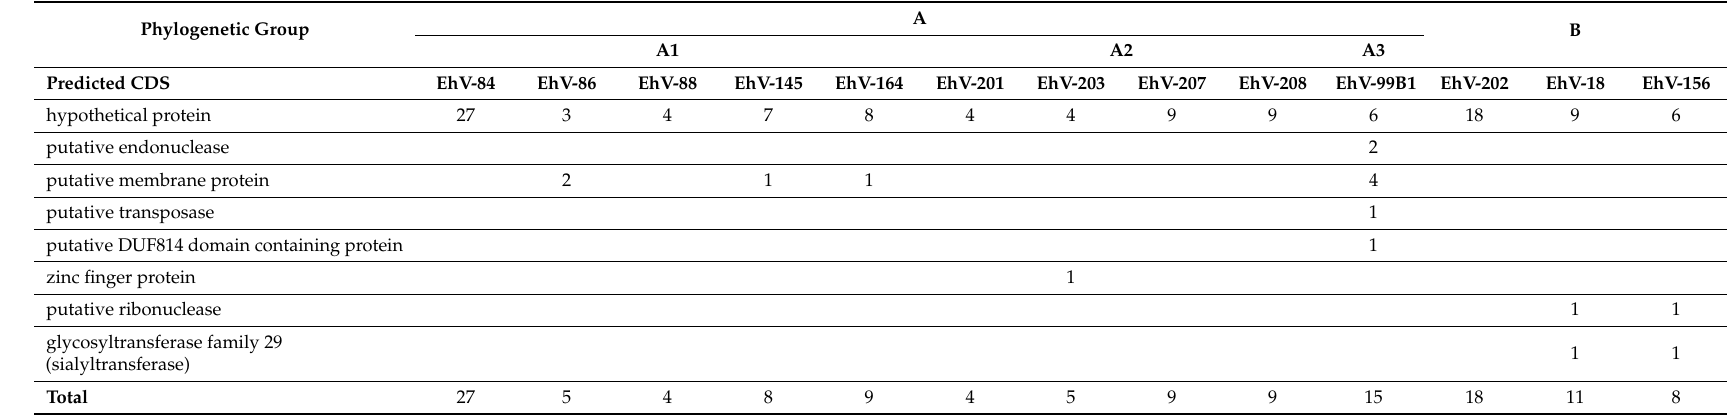
Table 5. Coccolithovirus strain-specific CDSs that are not shared among the different viruses and are “unique” to each strain. Analysis was done using the “build in above the column headers (see Figure